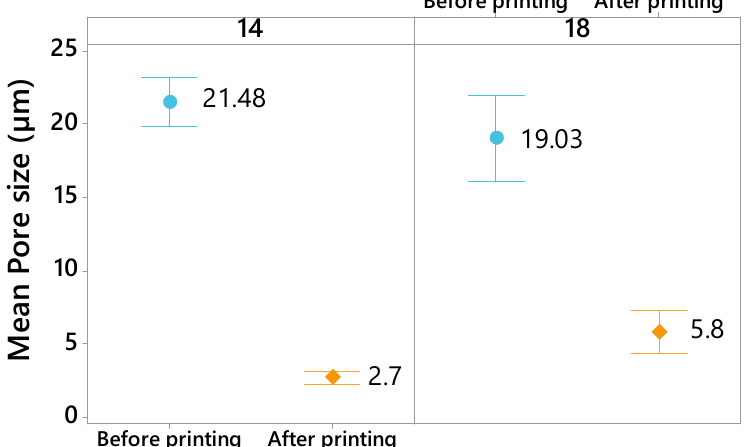
Figure 10. Mean pore size ( µ m) of the pores localized at the surface of the textile fabrics before 3D printing (in purple) and the 3D-PPOT materials after 3D printing (in yellow) depending on the fabric pattern (plain and twill).